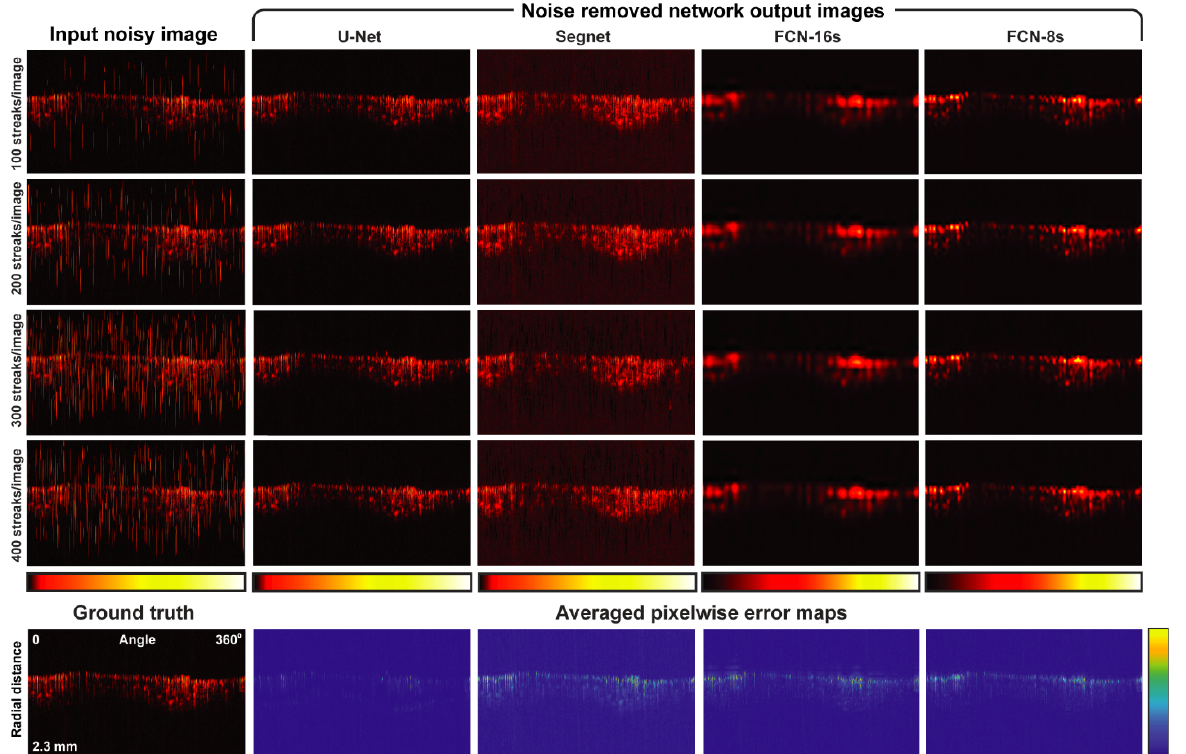
Figure 4. Visualized noise removal example for a single B ‐ scan image with different noise levels. The noise removal performance of each architecture is shown as a pixelwise error map, which calculates the difference between the ground truth and averaged network outputs from all tested noise levels. Further comparison with classical approaches can be found in Supplementary Figure S3.